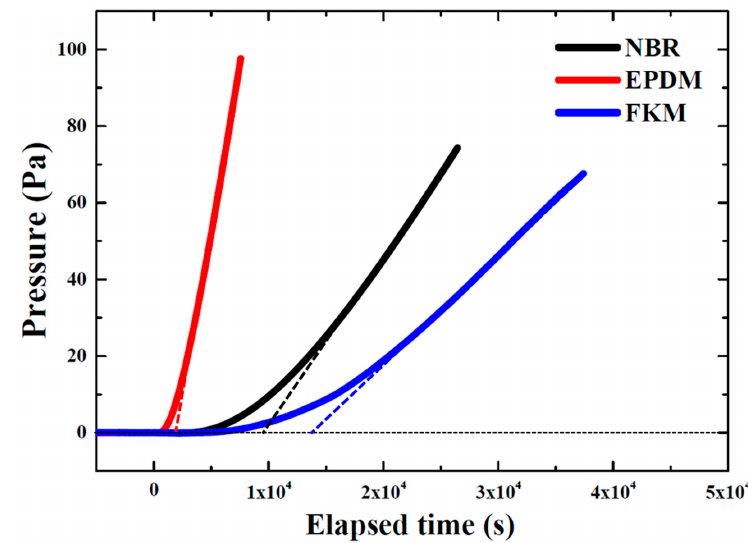
Figure 3. Permeability results of NBR, EPDM, and FKM. Table 2. Hydrogen permeation parameters of NBR, EPDM, and